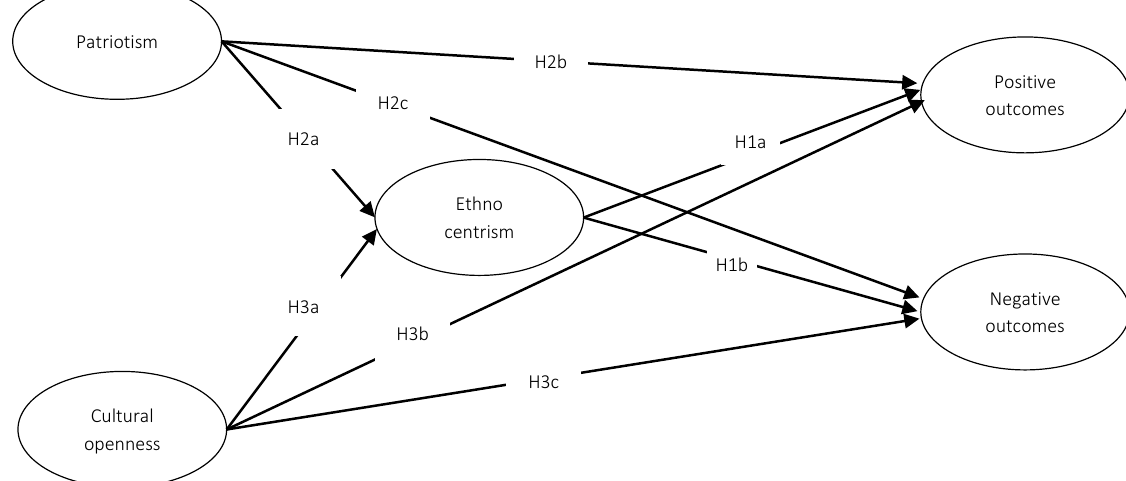
Figure 1. Proposed model of the